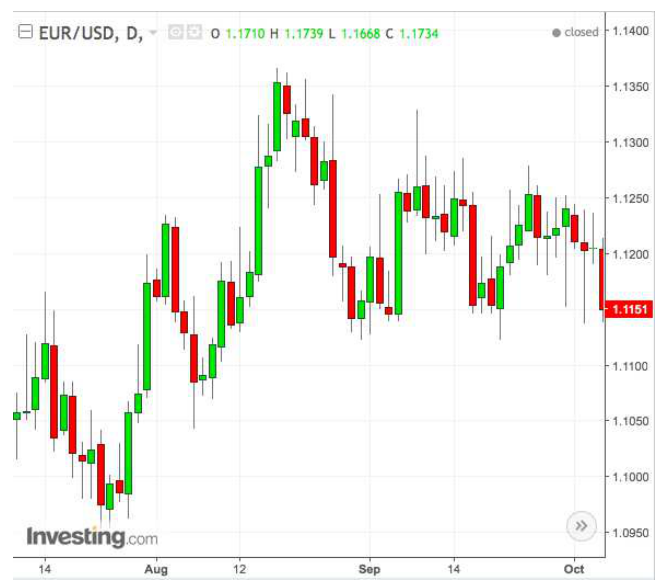
Figure 1. Dynamics of the EUR/USD pair at the beginning of October